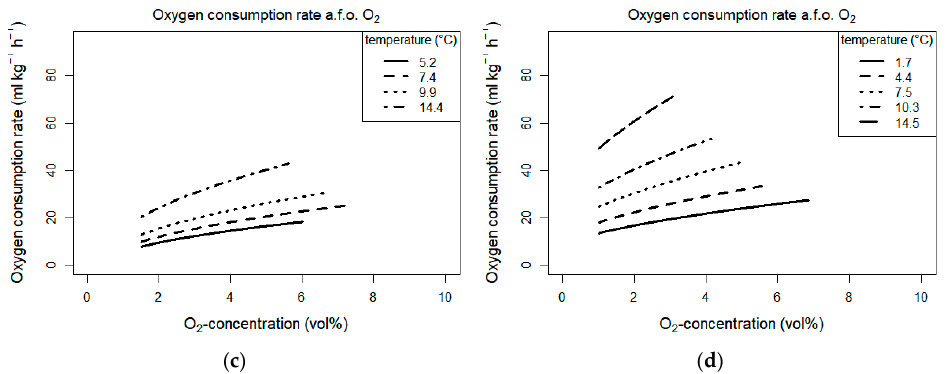
Figure 3. Oxygen consumption rate as a function of O 2 concentration for the different temperatures for ( a ) Phalaenopsis February; ( b ) Phalaenopsis March; ( c ) Chrysanthemum cv. B; ( d ) Chrysanthemum cv. C. The OCR ’s were calculated from the models and plotted as a function of temperature for five different O 2 concentrations (Figure 4) . The effect of the temperature is more pro- nounced at a higher O 2 concentration